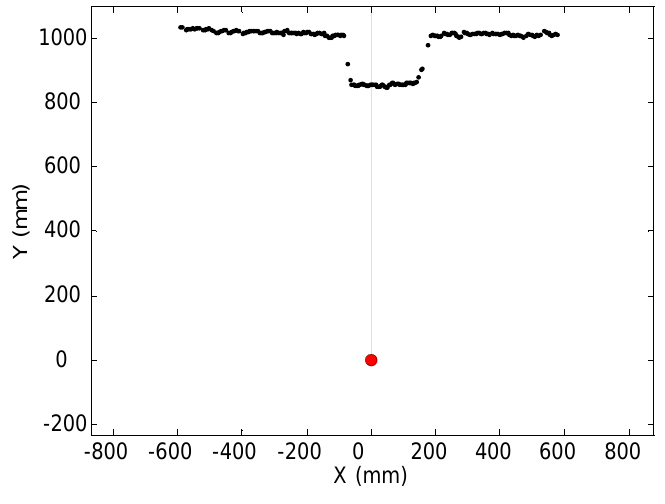
Figure 9. Example of LIDAR scan obtained in floor mode with an obstacle in the walking